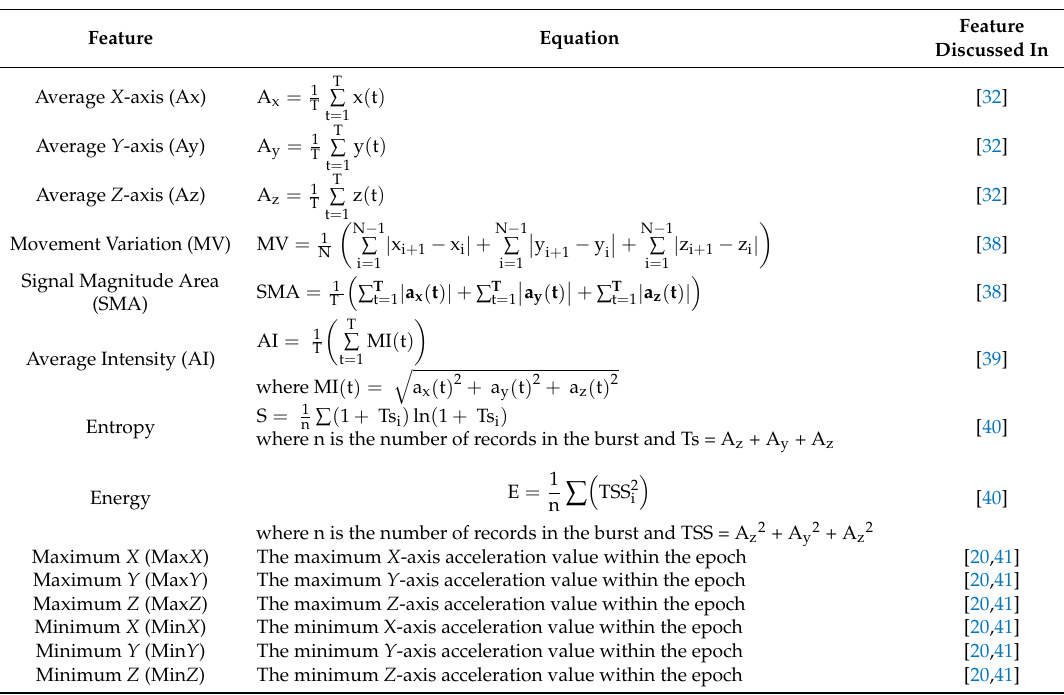
Table 2. Calculated features from raw X , Y , and Z acceleration